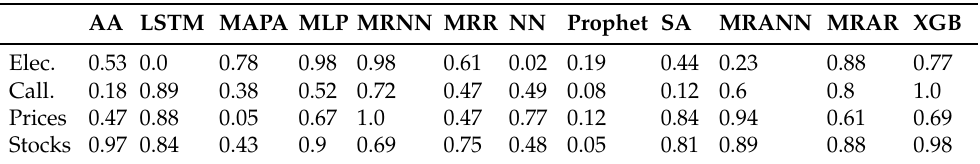
Table A2. The Kolmogorov–Smirnov statistic for testing if the forecast error with MASE follows an F distribution for all datasets and all forecasts for horizons > 1.